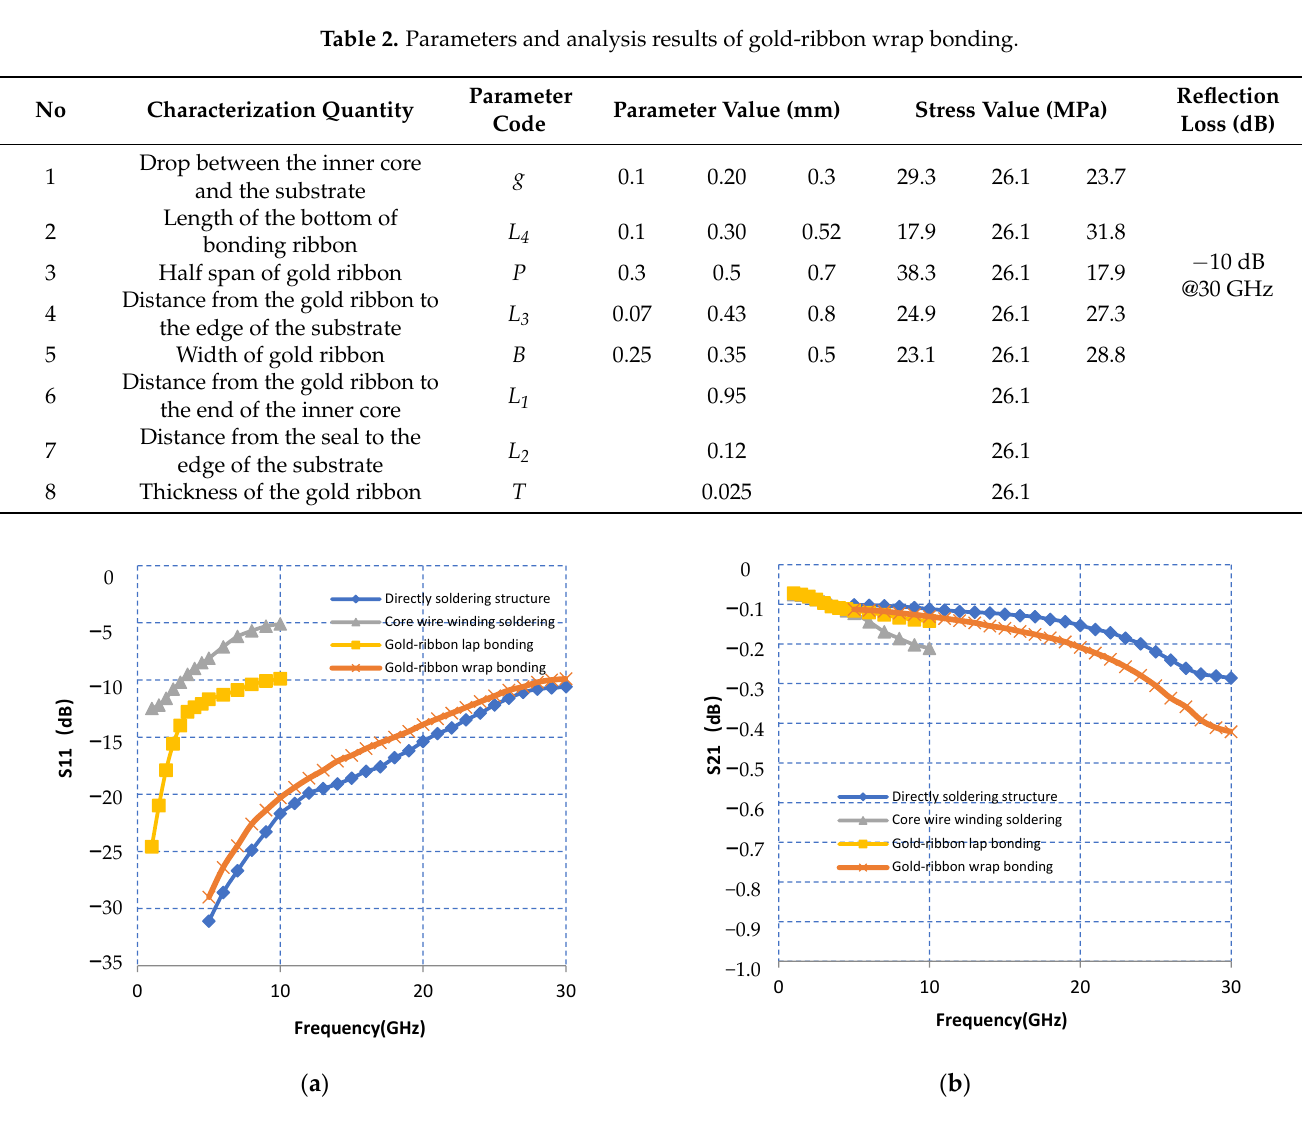
Figure 6. S-parameter of the above structures. ( a ) S11 of the above structures; ( b ) S21 of the above structures. Table 3. Stress simulation results of the above